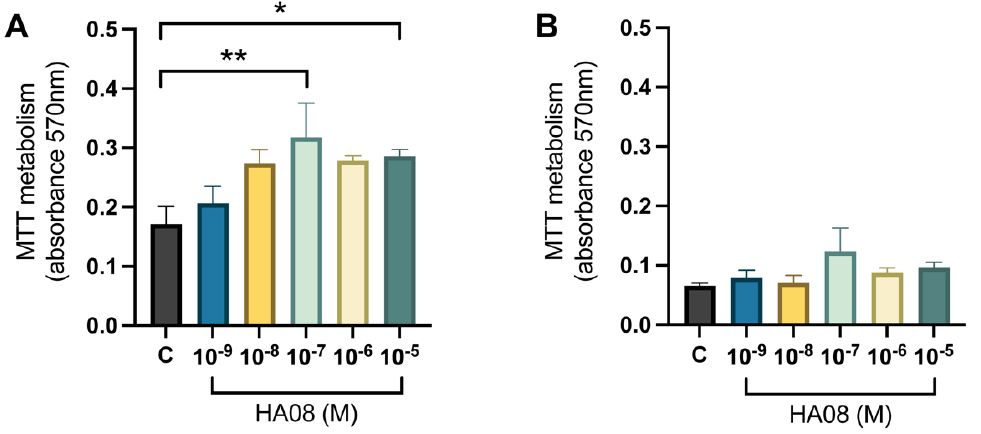
Figure 6. The effect of HA08 on mitochondrial activity. The results of the mitochondrial activity for ( A ) hippocampal cells and ( B ) cortical cells after HA08 treatment. The control cells (C) were treated with 1 × 10 − 4 M hydrogen peroxide from days 8–9 and 0.1% DMSO from days 9–10. The remaining treatment groups (HA08 10 − 9 , 10 − 8 , 10 − 7 , 10 − 6 , 10 − 5 M) were treated with 1 × 10 − 4 M hydrogen peroxide from days 8–9 and HA08 of respective concentration days 9–10. There was a significant increase in mitochondrial activity at HA08 concentrations 10 − 7 and 10 − 5 M compared to control cells data are presented as means ± SEM, * p -value < 0.05, ** p -value <